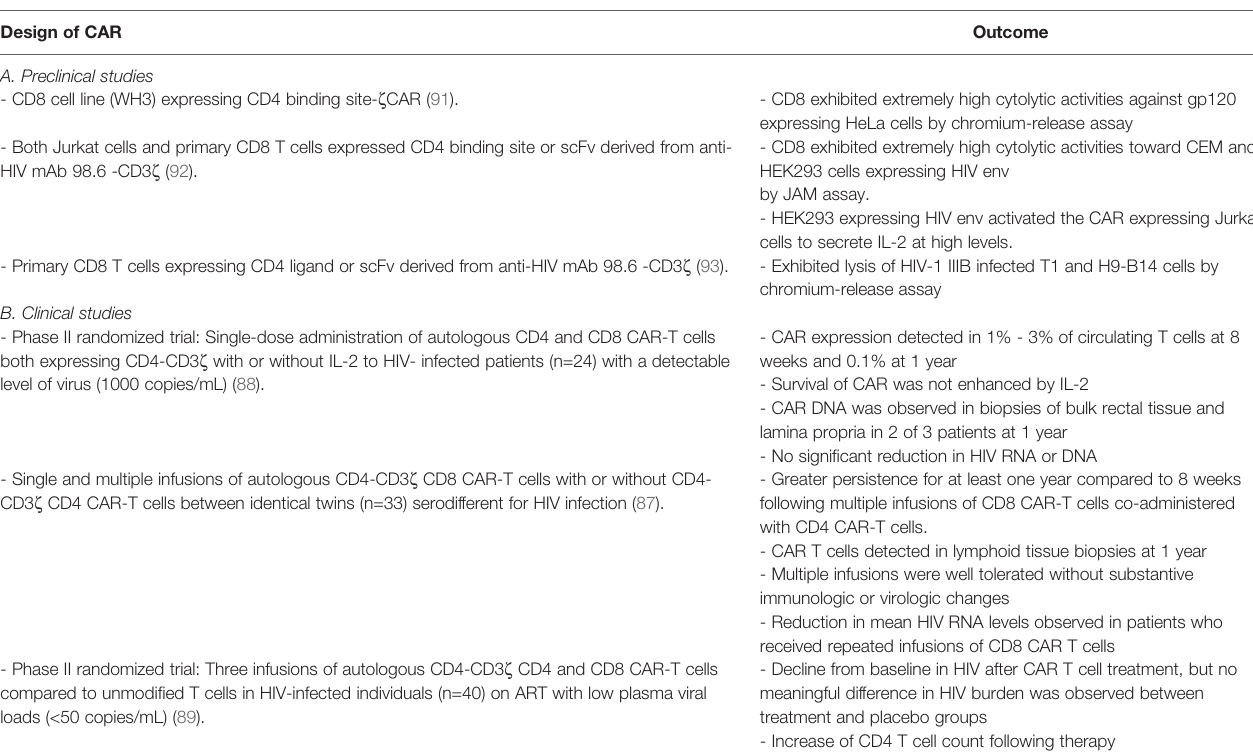
TABLE 2 | Preclinical and clinical testing of fi rst-generation anti-HIV CAR-T cells. Design of CAR